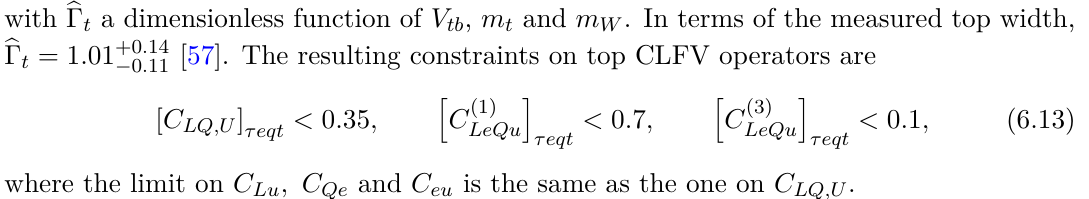
Figure 10 . Observed and background events in pp → eτ , at 36.1 fb − 1 , as a function of the τ -electron invariant mass m uncertainty on the backgrounds. The red, magenta and green lines denote the sum of the background and signal events induced by SMEFT